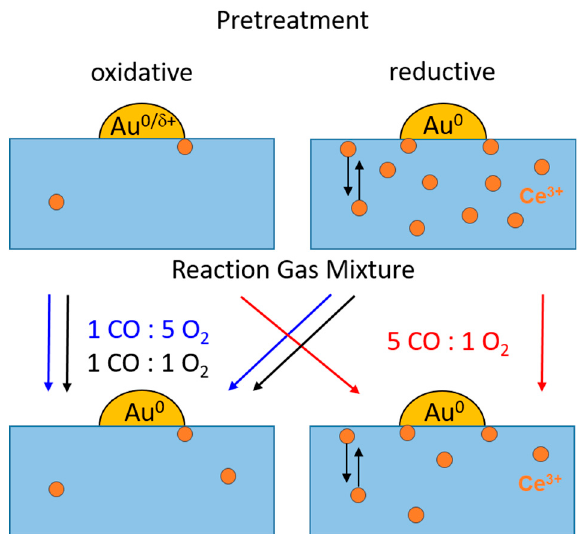
Figure 8. Schematic overview illustrating the O-vacancy and Ce 3 + concentration in Au / CeO 2 catalysts after oxidative (top left) and reductive pretreatments (top right) and during CO oxidation (bottom) in the di ff erent reaction gas mixtures used in this study (left: O 2 rich or standard reaction gas mixture, right: CO rich gas